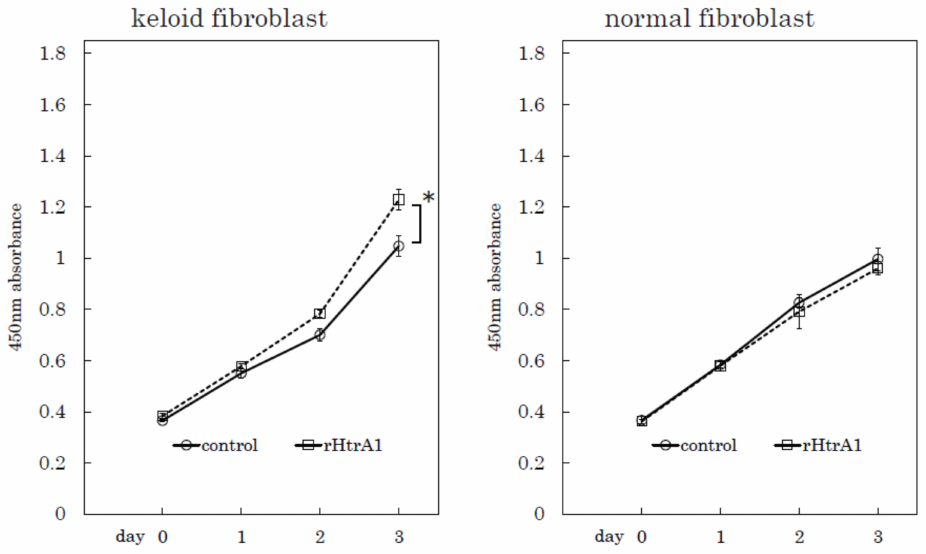
Figure 7. Proliferation rates of keloid fibroblasts and normal fibroblasts incubated with or without recombinant HtrA1. Proliferation curves of keloid fibroblasts obtained from sample No. 29 and normal fibroblasts from sample No. 8 as shown in Table 1, incubated with (rHtrA1) or without (control) recombinant HtrA1. n = 3, * p <